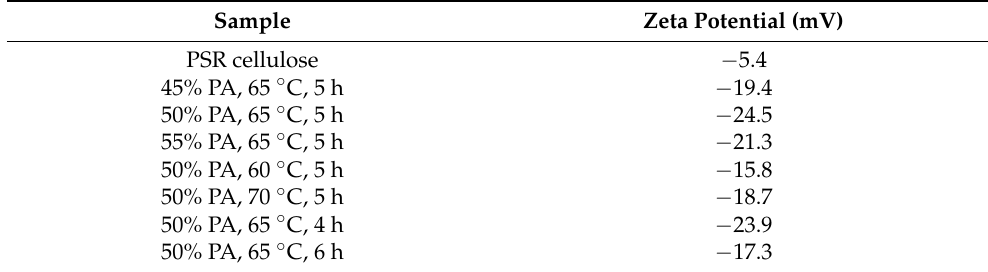
Table 5. Zeta potential values of CNCs prepared by ZrP co-catalyzed